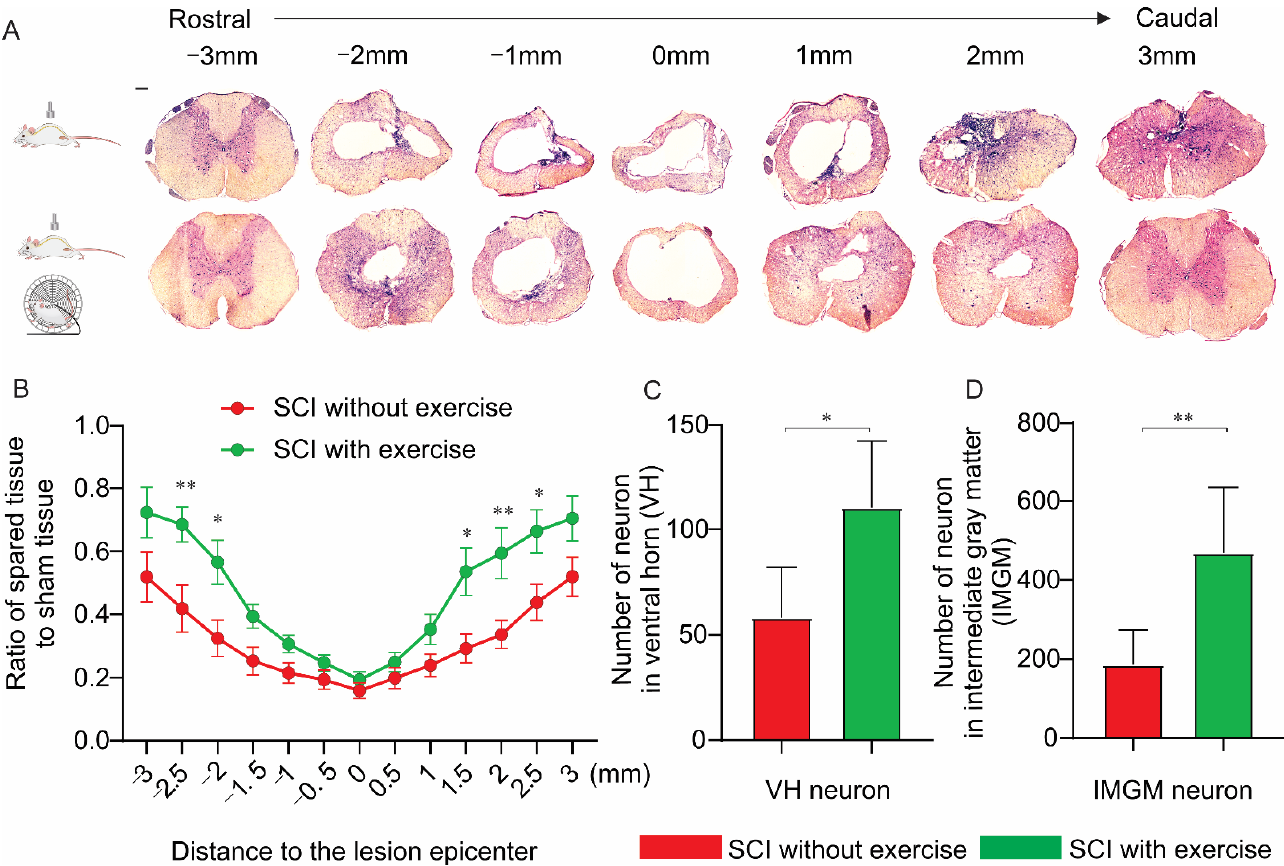
Figure 6. Locomotor exercise spares spinal-cord tissue. Morphometric analysis of spinal-cord lesion. ( A ) HE staining of cross-sections of injured spinal cord at various distances from injury epicenter (both rostrally and caudally) for all experimental groups at 16th week postinjury. ( B ) Percentage of spared tissue calculated by normalizing area of spared tissue to total cross-sectional area of sham spinal cord. In the lesion epicenter, there was no difference in the spared tissue between groups with and without exercise. In the location rostral and caudal to the lesion center, exercise group had more spared spinal tissue. ( C , D ) Group with exercise had more neurons in the ventral horn (VH) and in intermediate gray matter (IMGM) than the group without exercise did. *: p < 0.05; **: p < 0.01; Scale bar 100 μ m.